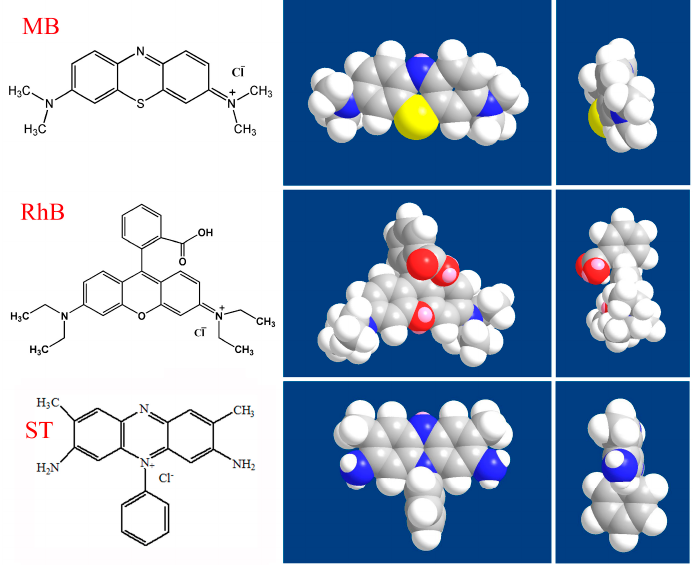
Figure 8. Fourier transform infrared (FT-IR) spectra of MXene and the obtained MXene/dye composite LB films.